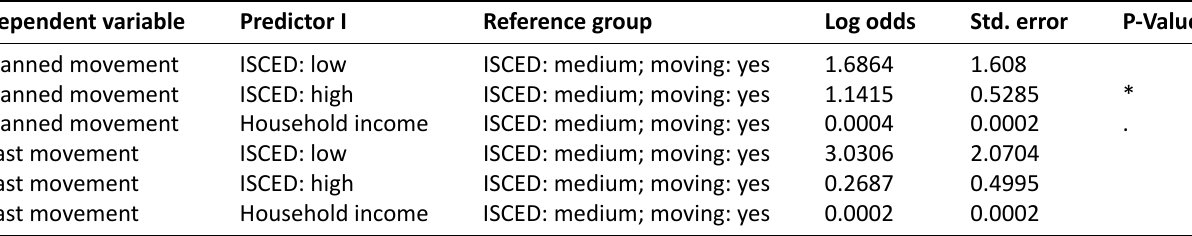
Table 4. Results of the multivariate binomial logistic regression with interaction between household income and